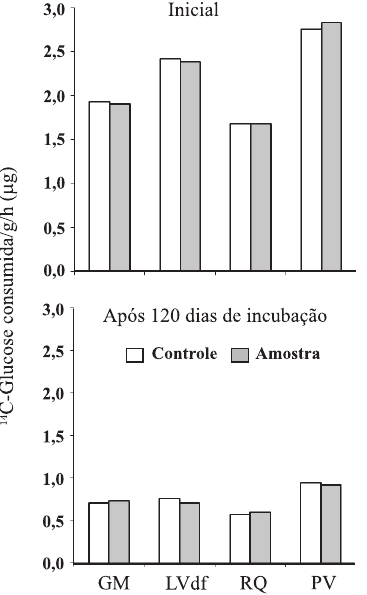
Figura 5. resultados de radiorespirometria para os solos gm, lvdf, rQ e pv no início e após 120 dias de